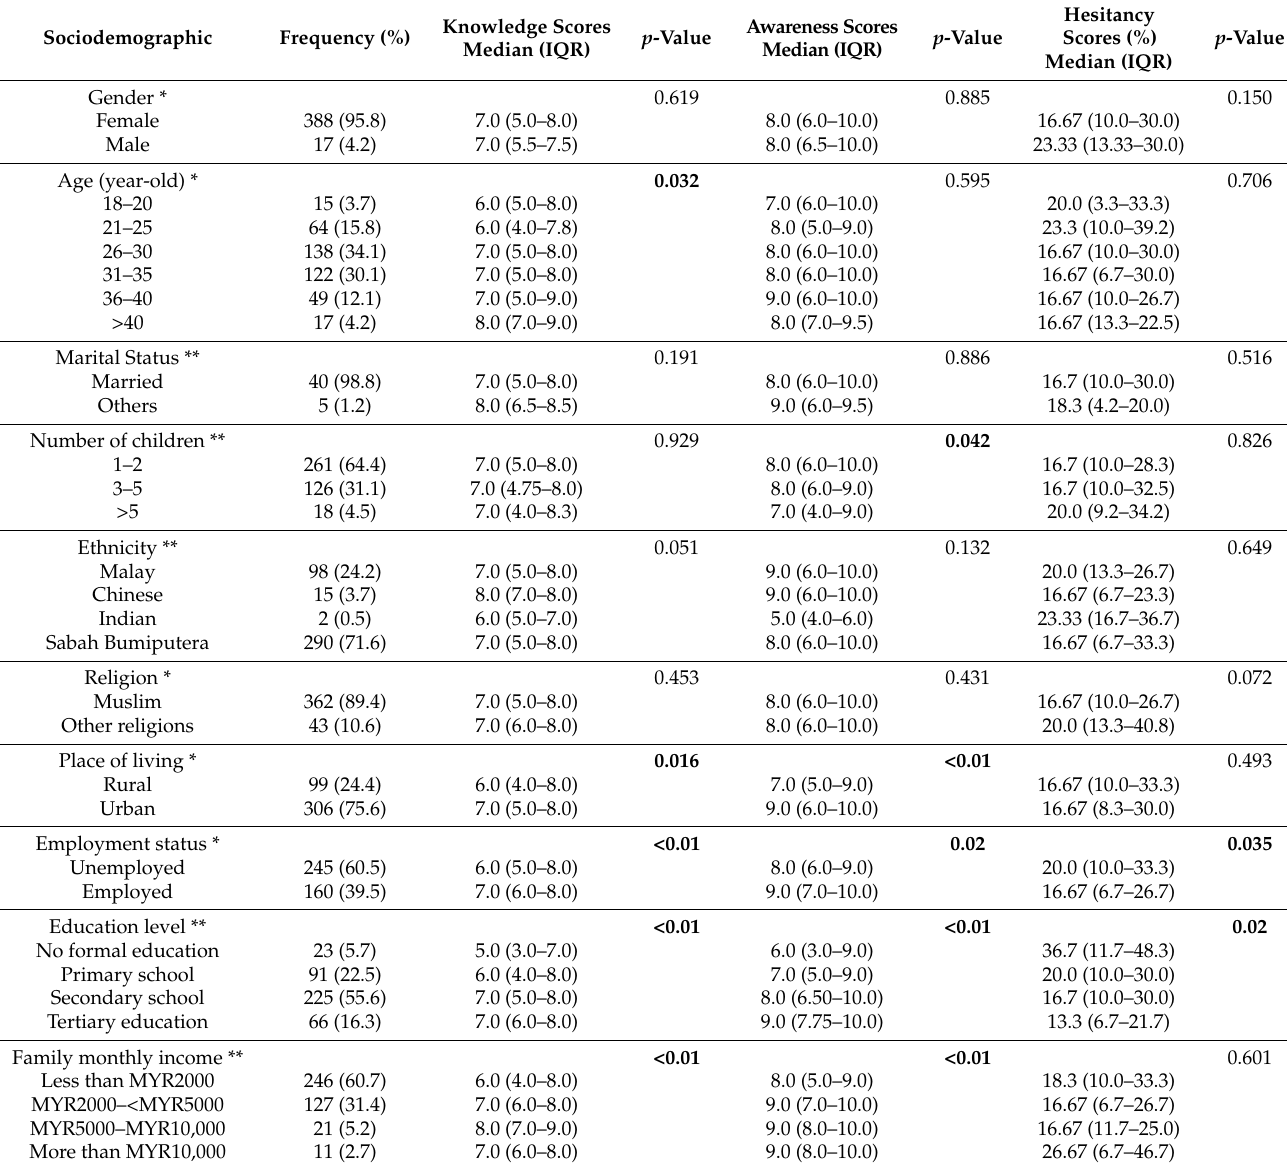
Table 1. Total Vaccine Knowledge, Awareness, and Hesitancy Score by Parents’ Sociodemographic